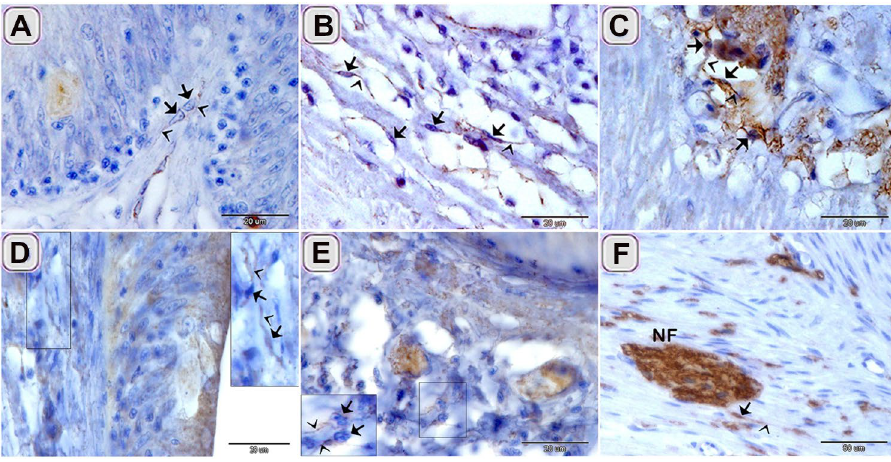
Figure 10. Immunohistochemical staining of the intestinal blub using desmin and S100-protein counter stain by HX. Immunostained paraffin sections of the intestinal blub for desmin ( A – C ) and S100-protein ( D – F ). ( A ) desmin positive sub-epithelial TCS (arrows). ( B ) desmin positive TCs (arrows) in the lamina propria. ( C ) desmin positive TCs (arrows) between the muscle bundles. ( D ) S100-protein positive TCs (arrows) under the epithelium. ( E ) S100-protein positive TC (arrows) between the muscle bundles. ( F ) S100-protein positive TC (arrows) connected with nerve fiber (NF). Note: Telopodes (arrowheads).